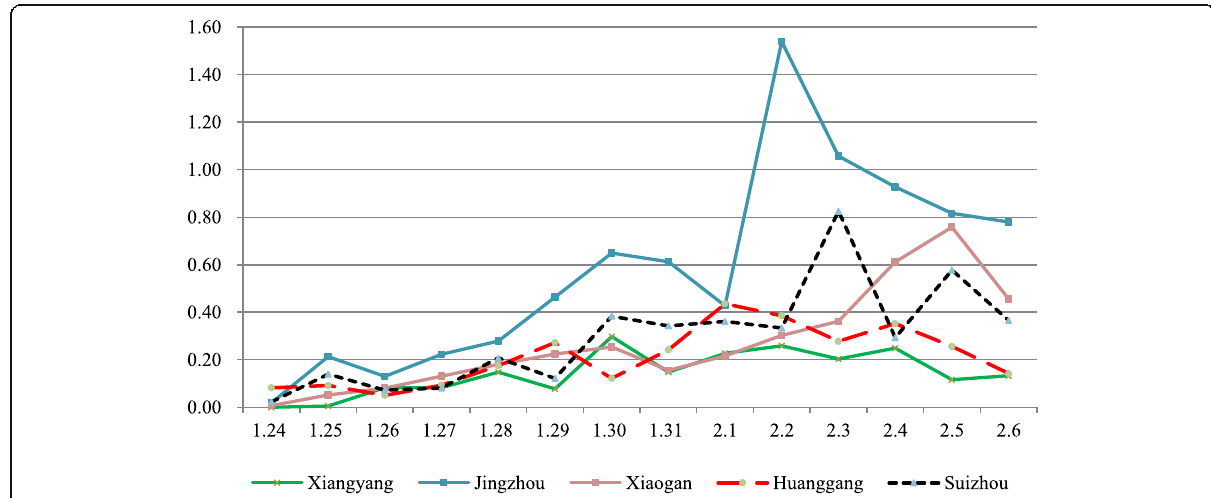
Fig. 4 Daily diagnosis rate of COVID-19 per 10,000 persons in 5 prefecture-level cities in Hubei Province from January 24th to February 6th,